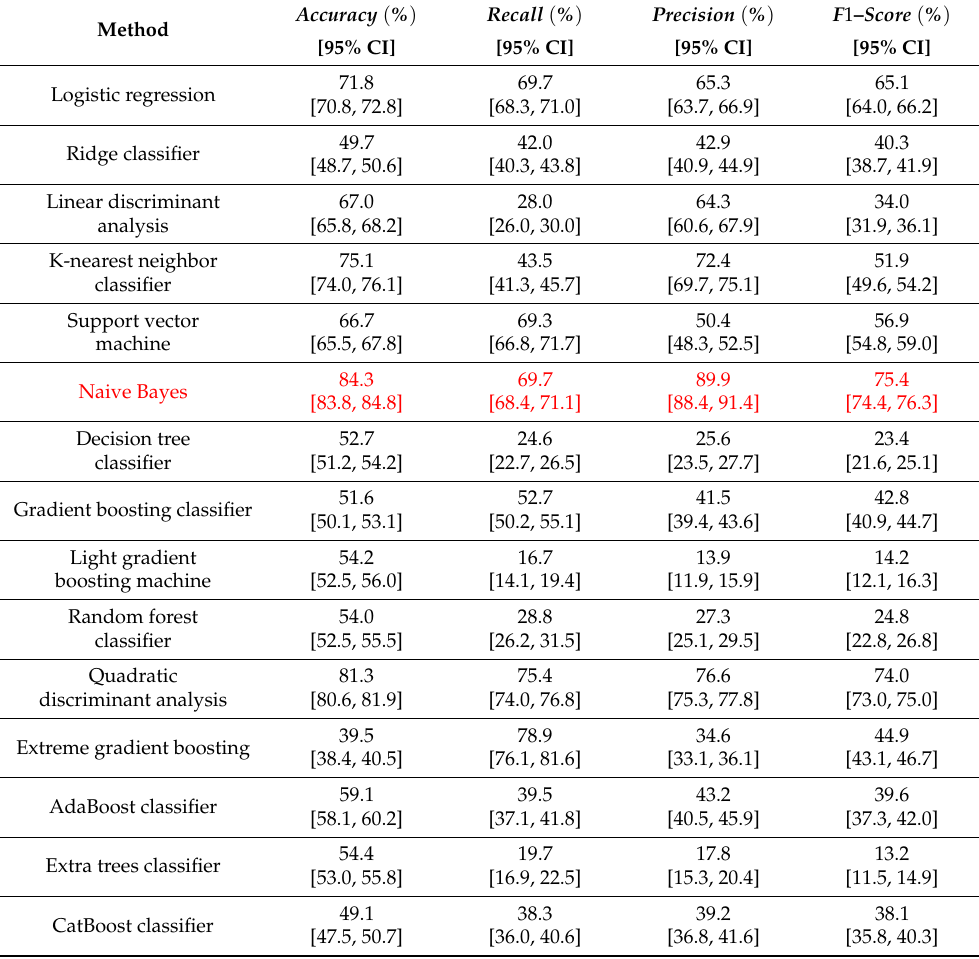
Table 5. Averaged accuracy , recall , precision , and F 1 − score and their 95% CI of 15 ML methods using hemodynamic features with whole hemodynamic features for classification of AD and WT. Each method was performed 600 times by shuffling the data due to limited data sets. The results and the name of the ML method with the best accuracy (naive Bayes) are highlighted in